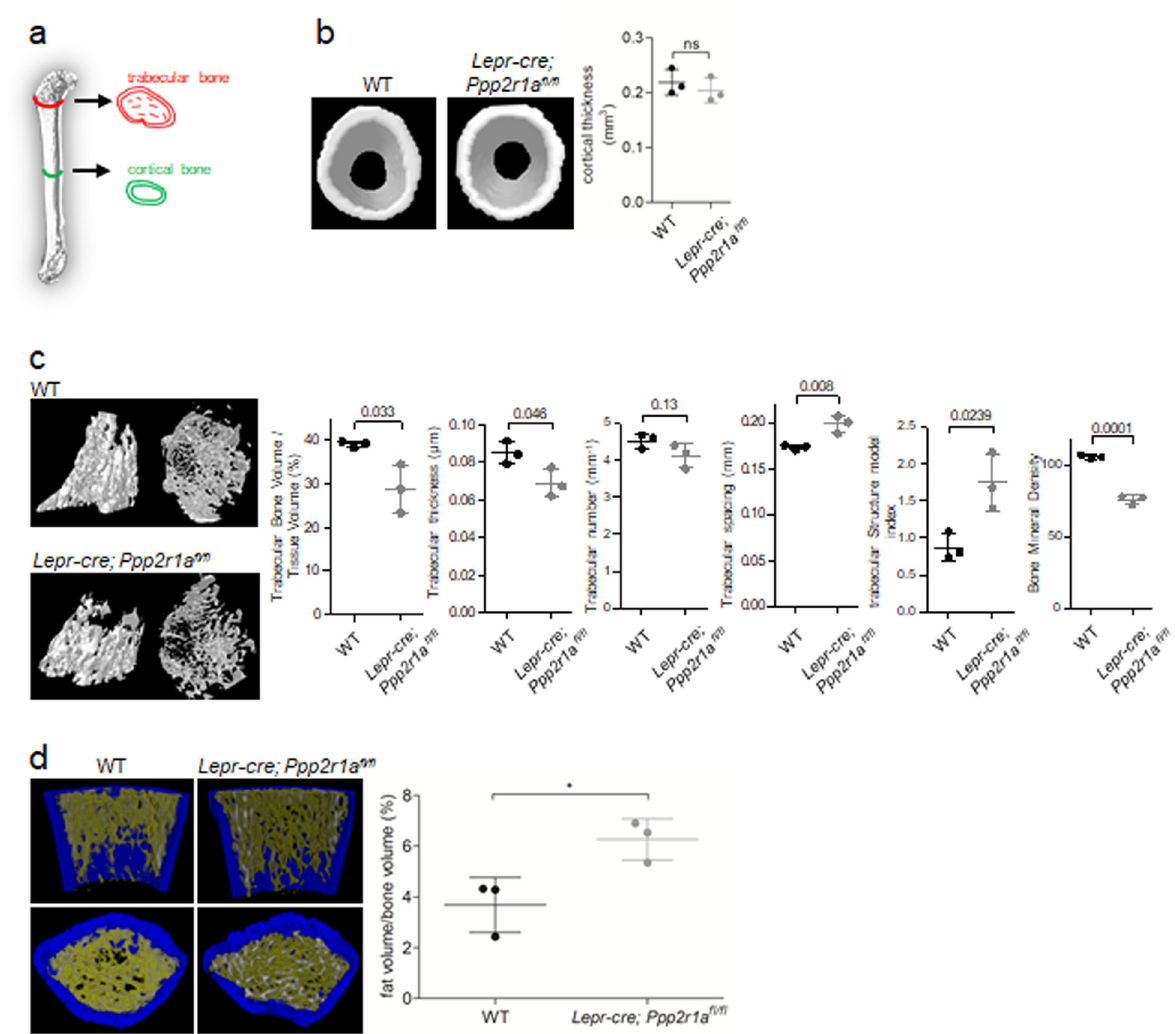
Fig. 5 The Lepr-cre; Ppp2r1a fl / fl mice exhibited reduced bone density and increased fat density in trabecular bones. Micro-CT analysis of femur in Lepr- cre; Ppp2r1a fl / fl mice and relative WT littermates at P30. a Illustration of areas scanned for cortical and trabecular bone. b left Morphological characteristics of femur cortical bone. b right There is no signi fi cant difference in cortical thickness between Lepr-cre; Ppp2r1a fl / fl mice and relative WT littermates. c left Morphological characteristics of femur trabecular bone. c right Quanti fi cation of micro-CT data on trabecular bone volume fraction (Trabecular Bone Volume / Tissue Volume, %), trabecular thickness ( μ m), trabecular number (mm − 1 ), trabecular spacing (mm), trabecular structure model index, and bone mineral density ( p values represent in number on top of each assessment as determined with Student ’ s t -test). d left Trabecular bone architecture in WT and Lepr-cre; Ppp2r1a fl / fl mice with labeling using software analysis of μ CT sections (blue: cortical bone; white: trabecular bone; yellow: fat). d right Comparison of fat volume/bone volume (%) in μ CT image analysis of Lepr-cre; Ppp2r1a fl / fl and relative WT littermates. n = 3 mice; Data are mean ± s.d. * p < 0.05 as determined with Student ’ s t -test. ns, not signi fi